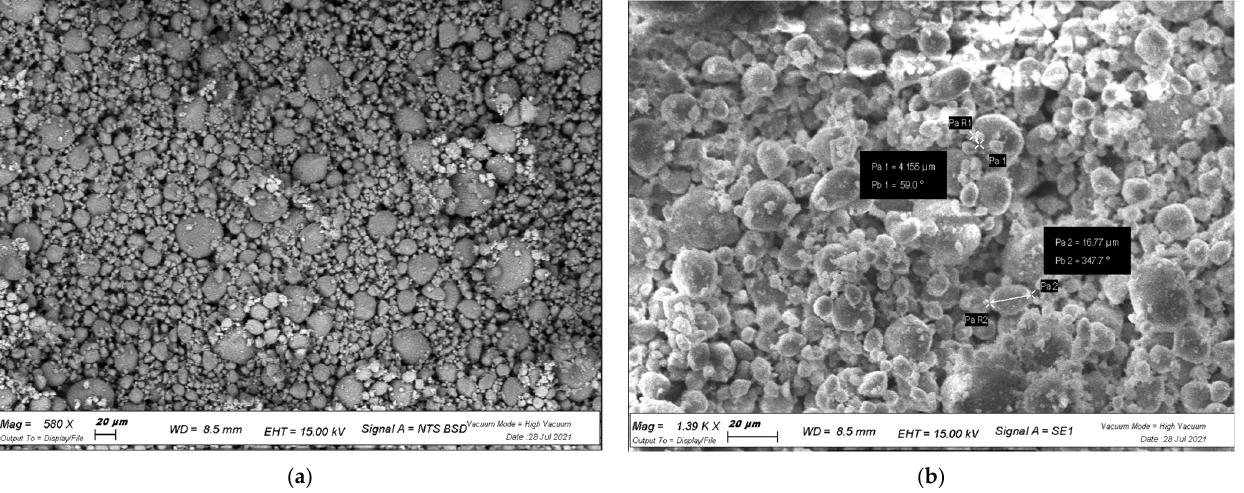
Figure 6. SEM image of non-nanometric Titanium Dioxide, Silica, Jojoba Esters at different magni- fications: ( a ) 500× magnification; ( b ) 1390× magnification.